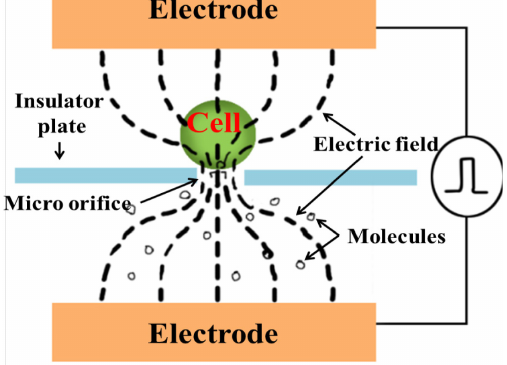
Figure 5. Microfluidic SCEP with cell trapping. Figure has been redrawn with reference